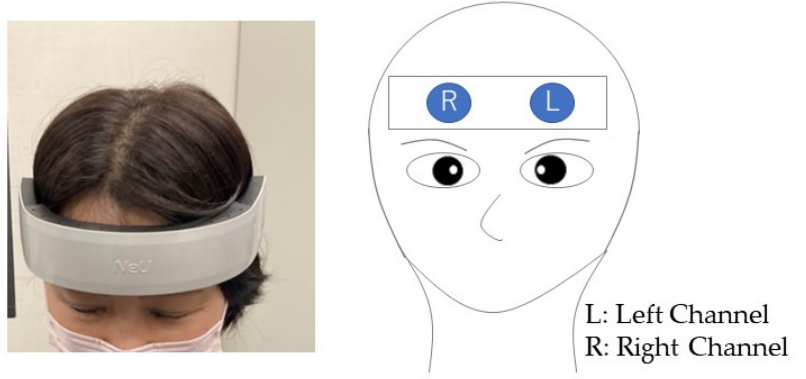
Figure 4. Probe set in in the frontal lobe.